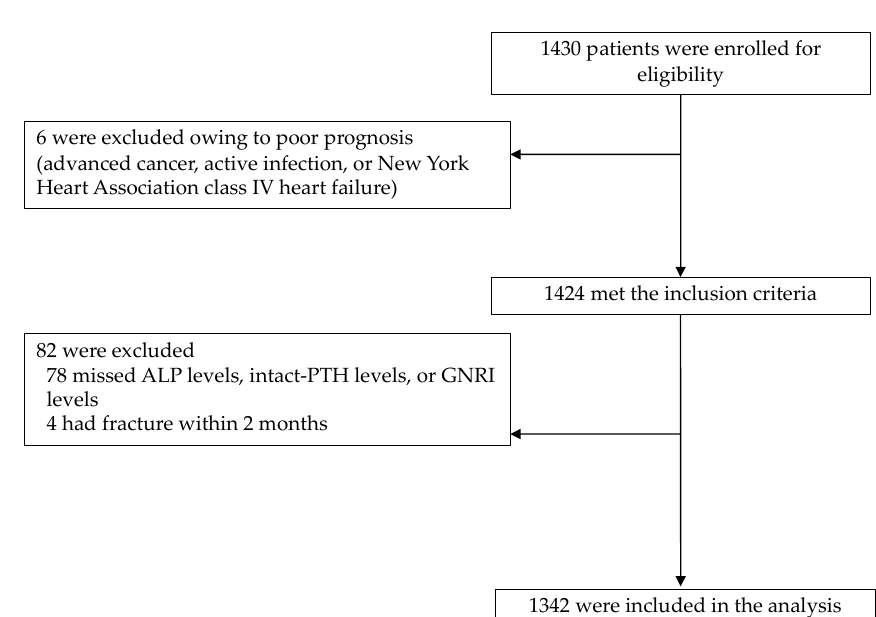
Figure 1. Flow chart of the cohort. Abbreviations: CRP, C-reactive protein; GNRI , geriatric nutritional risk index; intact-PTH, intact parathyroid hormone; ALP, alkaline phosphatase.